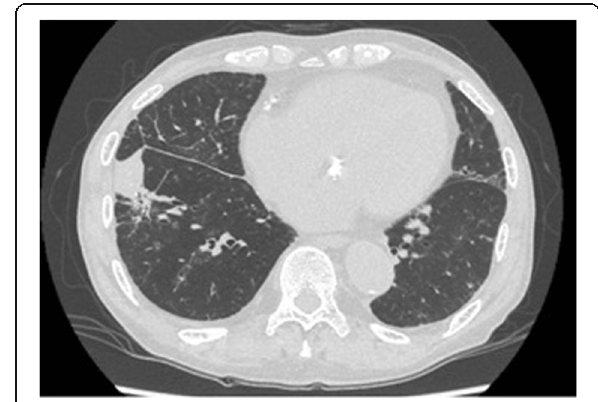
Fig. 4 Chest CT scan 8 months after TAVI. The nodule in the right lower lobe grew